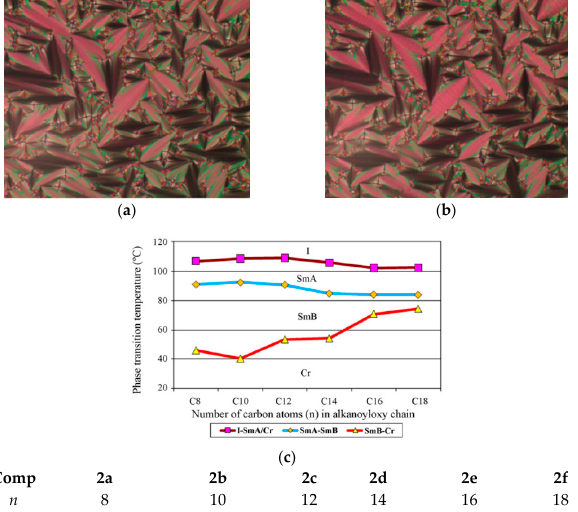
Figure 4. The optical photomicrograph of compound 2a , ( a ) temporary transition bars, ( b ) from smectic A to smectic B phase, and ( c ) plot of phase transition temperatures. Reprinted/adapted with permission from Ref. [26]; published by Elsevier,